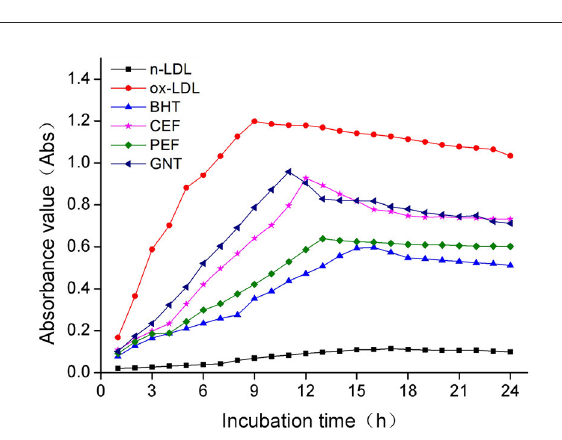
FIGURE7 Kinetic curves of the CD generation and degradation in different oxidation incubation systems.